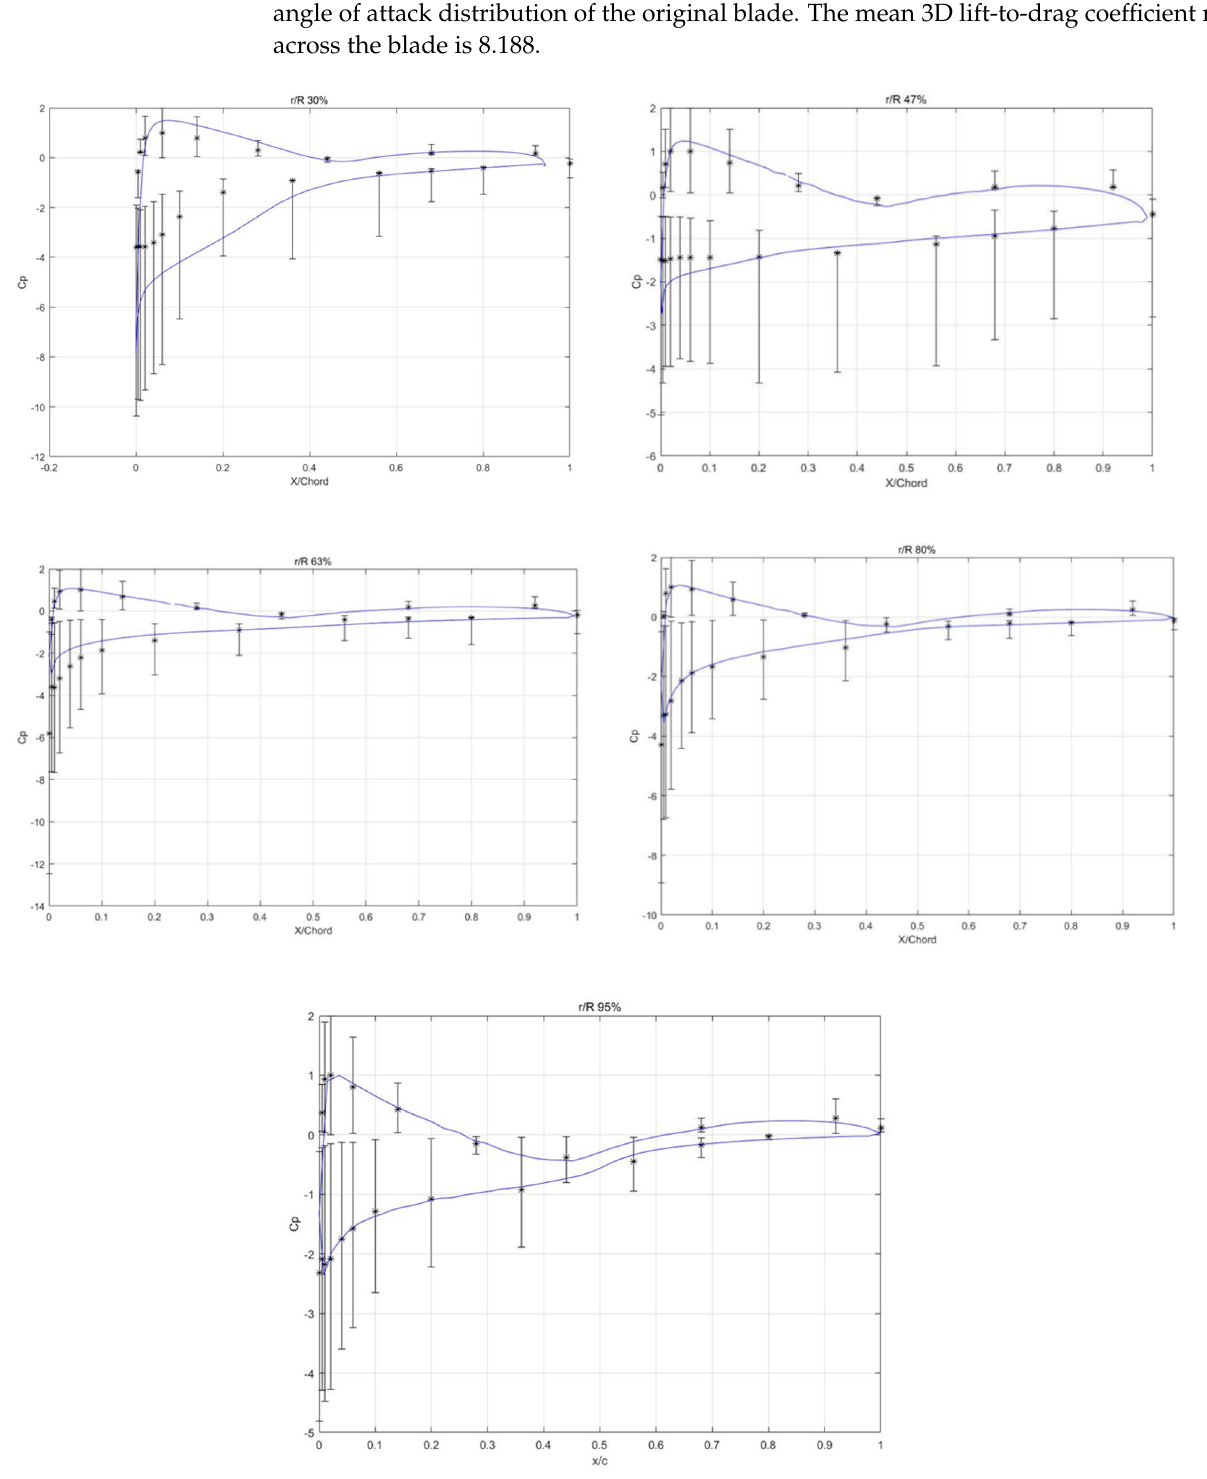
Figure 14. Pressure coefficients distribution for 10 m/s wind